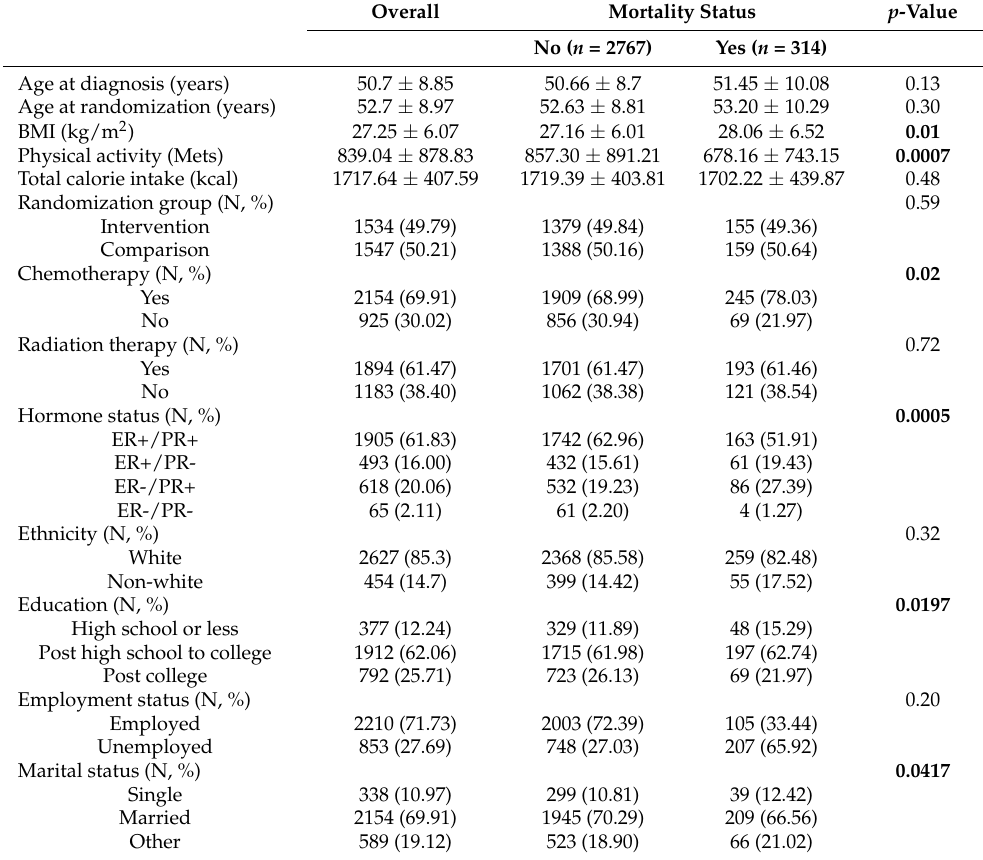
Table 1. Baseline demographics of the WHEL study participants ( n = 3081).